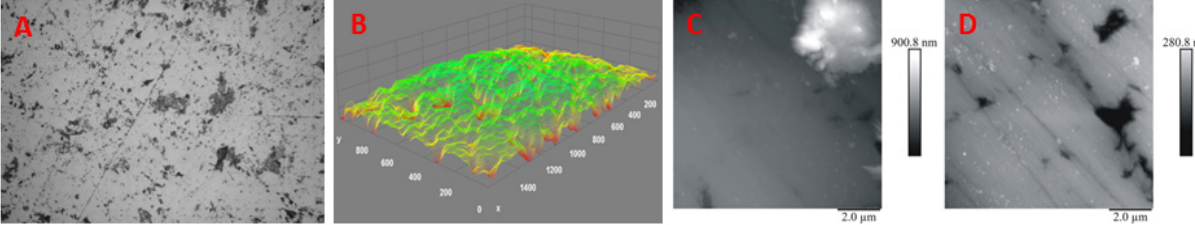
Figure 1. Optical image of the HAp film at 500 × magnification: ( A ) cross-sectional view generated from the optical image ( B ) and film thickness measurements using AFM ( C , D ).